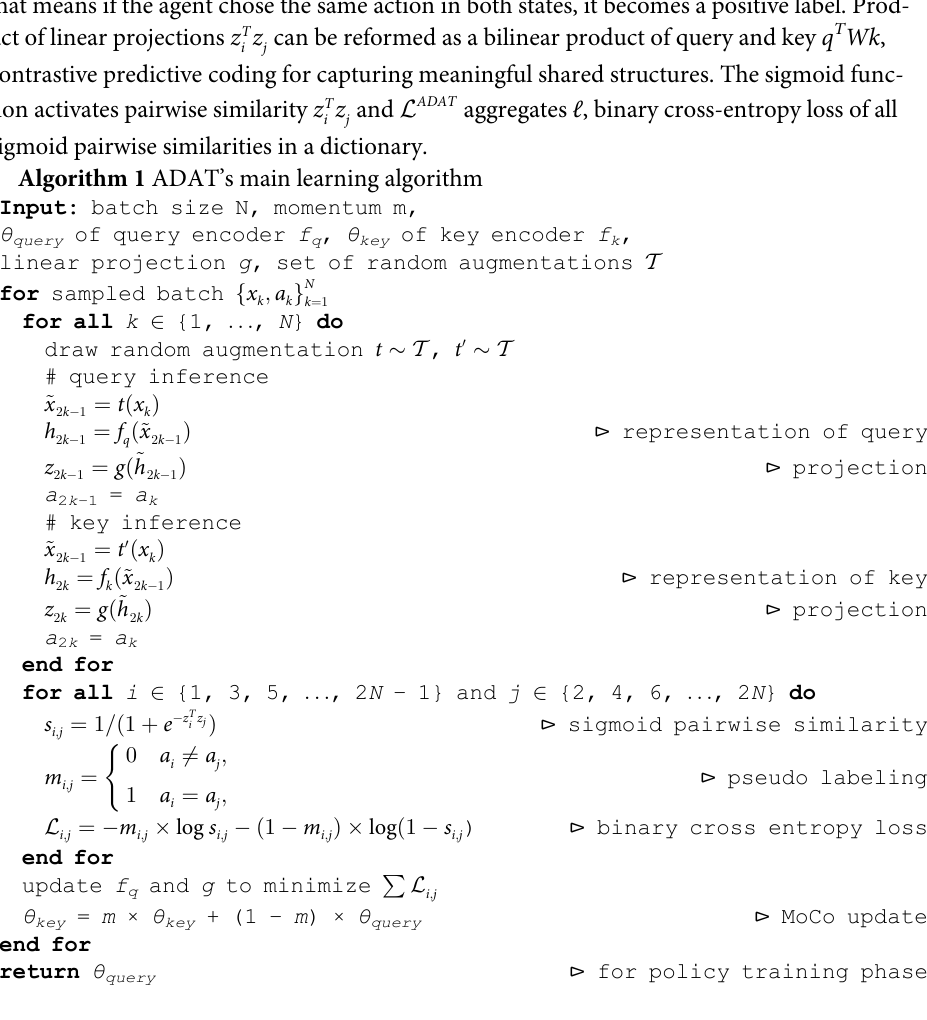
Algorithm 1 ADAT’s main learning